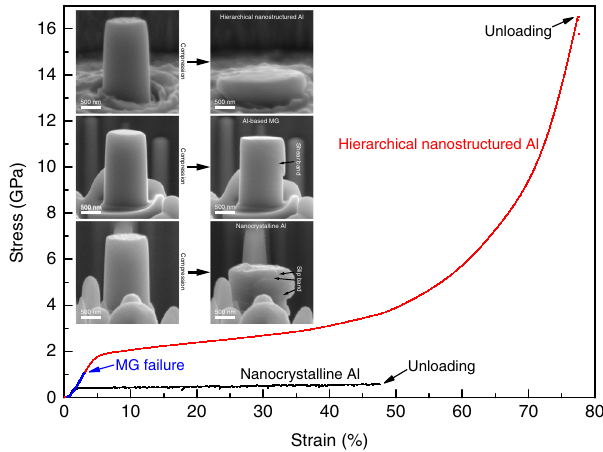
Fig. 3 Mechanical property of the hierarchical nanostructured Al alloy. Compressive engineering stress-strain curves of the hierarchical nanostructured Al alloy, Al-based MG and nanocrystalline Al pillar samples with the same diameter of 1 μ m. The insets are the SEM images of the samples before and after compression NATURE COMMUNICATIONS| (2019) 10:5099